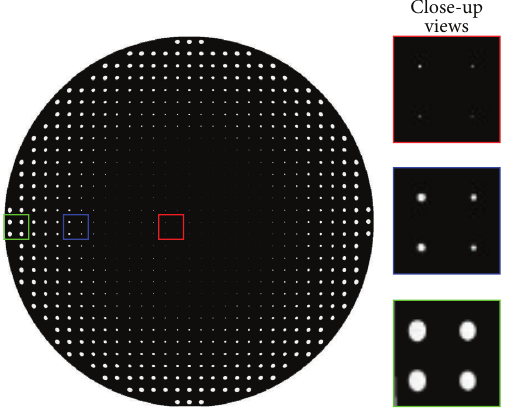
Figure 2: Simulation results of catadioptric omnidirectional imaging